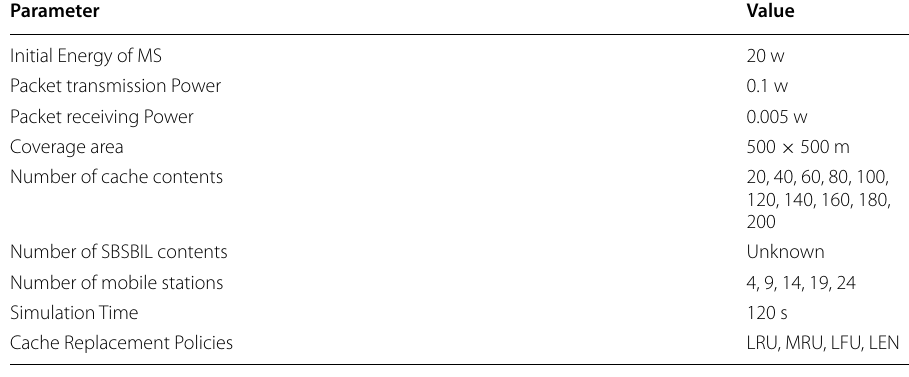
Table 3 Simulation parameters Parameter